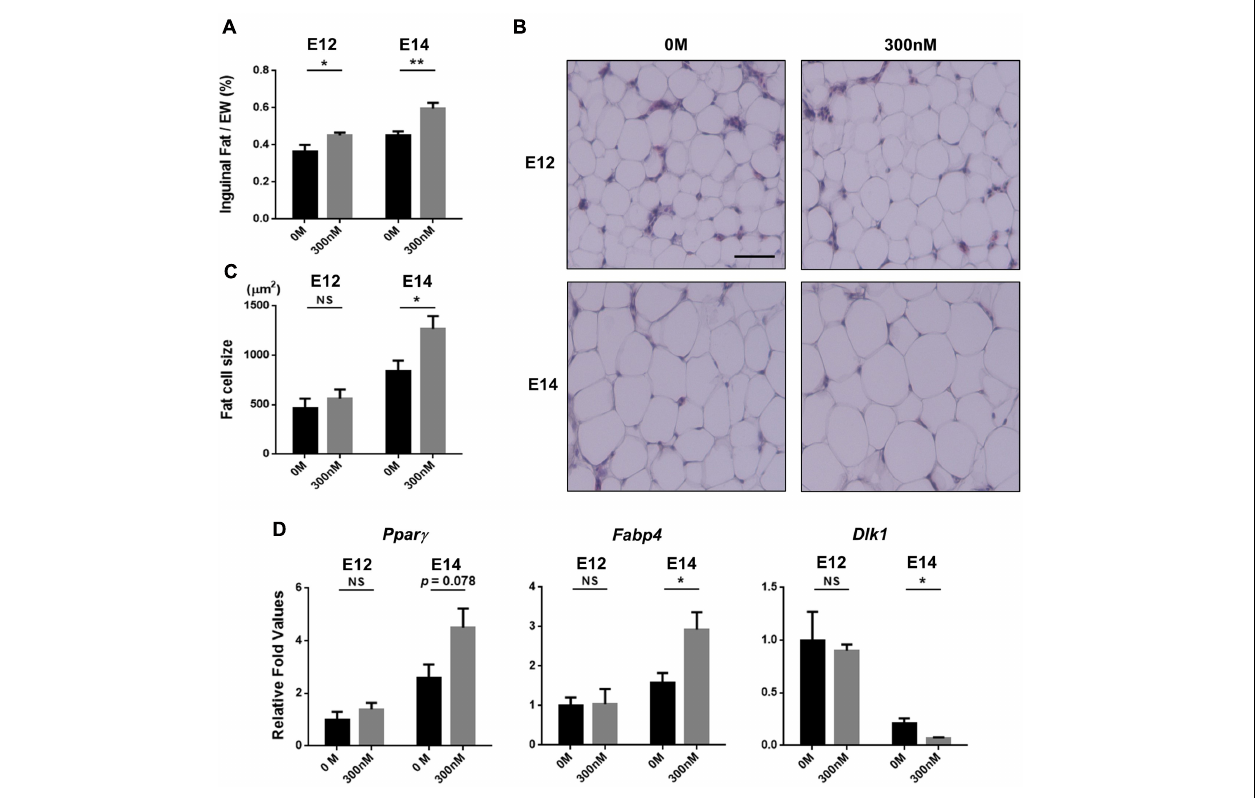
FIGURE 4 | Hypertrophic fat cells by in ovo injection of all- trans retinoic acid (atRA). Percentages of inguinal fat weights in embryo weight (EW) (A) . Embryos were injected with 0 M or 300 nM of atRA at E7 and sampled at E12 or E14. For 0 M or 300 nM of atRA, n = 9 and n = 9 embryos at E12 and n = 9 and n = 8 embryos at E14, respectively. Scale bar: 100 µ m. H&E stain of inguinal fat tissue (B) and comparisons of fat cell size (C) . Quantitative analysis of gene expression involved in adipogenesis by qPCR (D) . n = 4 for 0 M and 300 nM of atRA at E12 and E14, respectively. All data were expressed as means ± SEM. The data were analyzed by Student t -test using GraphPad Prism software, version 6.02. NS, no significance; * p < 0.05, ** p <